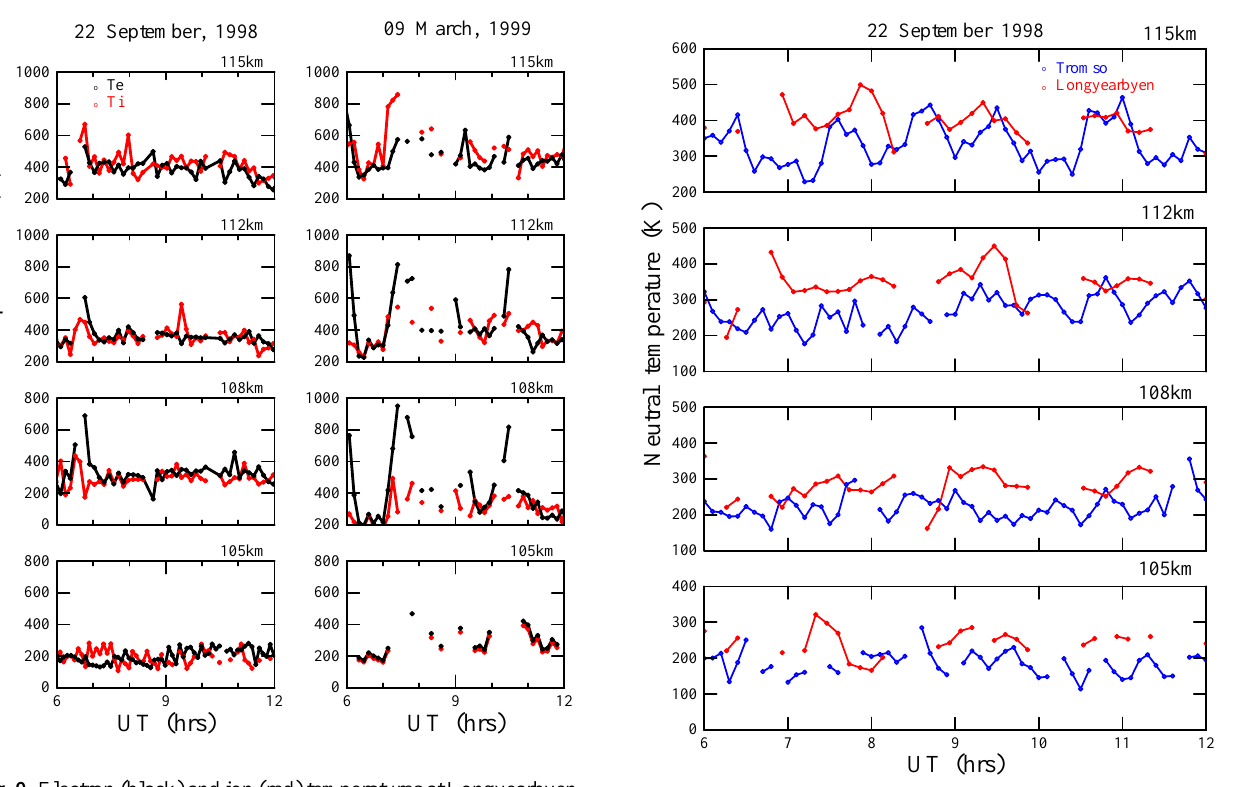
Fig. 10. Derived neutral temperatures between 105 and 115km at Tromsø (blue) and Longyearbyen (red) from 06:00 to 12:00UT on 22 September